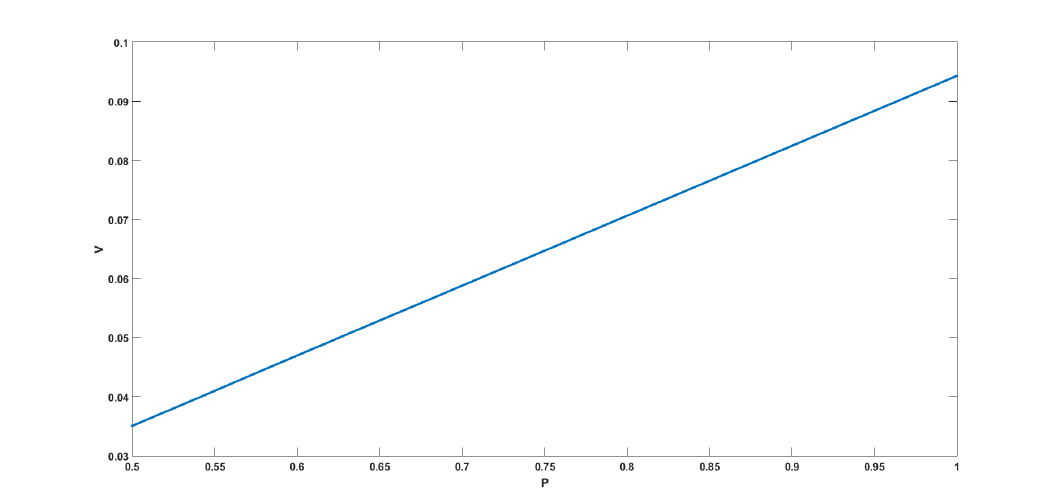
Figure 5. The shape of the value function v for ( x , p , θ , ρ , y ) ∈ D 1 in the plane of p . We plot the value function v for a fixed state ( x , θ , ρ , y ) in the plane of p s.t. ( x , p , θ , ρ , y ) ∈ D 1 and θ ∈ [ 0, m ] . As expected, v is nondecreasing w.r.t. p . The more expensive the resource is, the more the manager takes benefits.